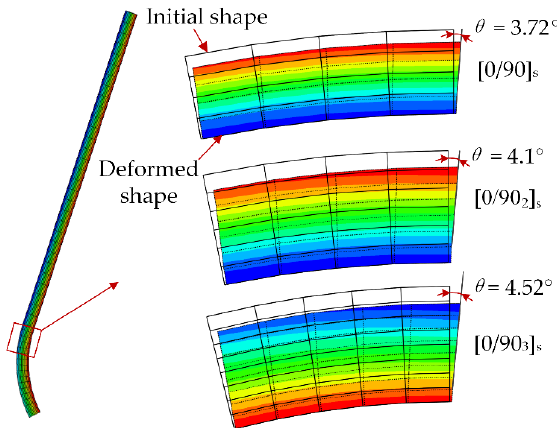
Figure 10. Predicted displacement nephogram of corner cross-section shape of L-shaped parts at the end of the rubbery stage. (The deformation scale factor is 20).